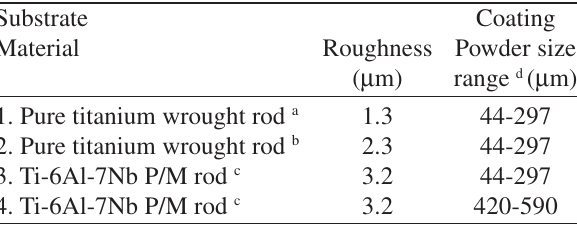
Table 1. Materials used to produce the substrates and the corre- sponding porous